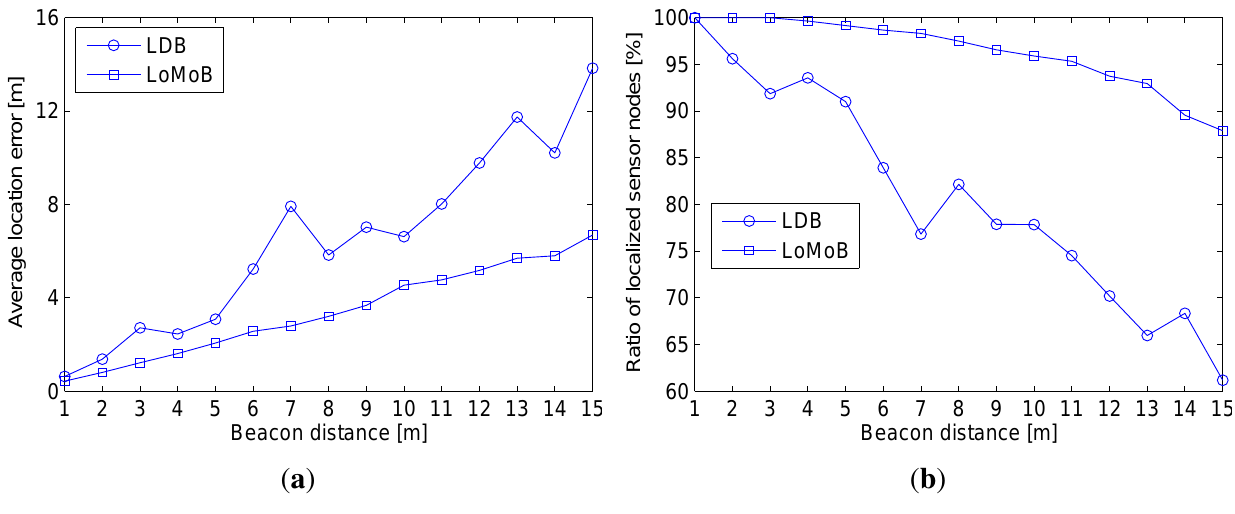
Figure 7. Localization accuracy as a function of beacon distance. ( a ) Average location error; ( b ) Ratio of localized sensor nodes.